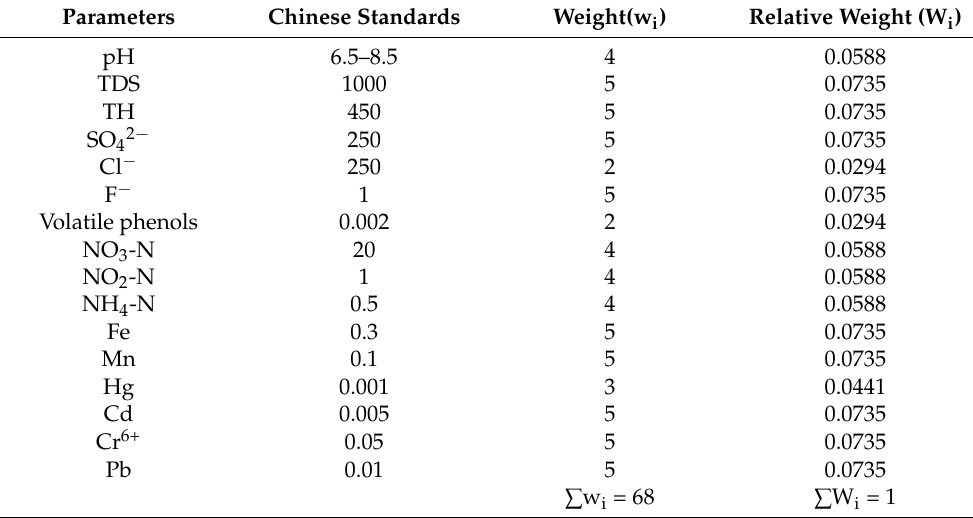
Table 4. Relative weight of hydrochemical